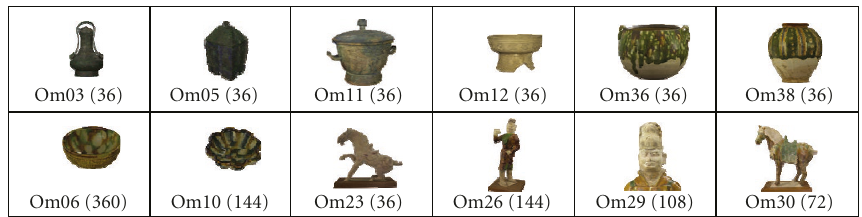
Figure 5: OMDB1: the index and number of images for some objects.